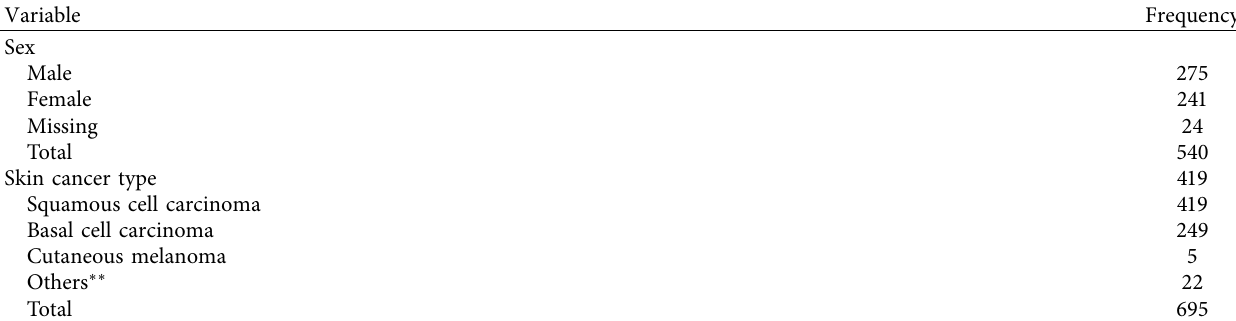
Table 4: Skin cancer type and sex of 540 African albinos with cutaneous malignancy